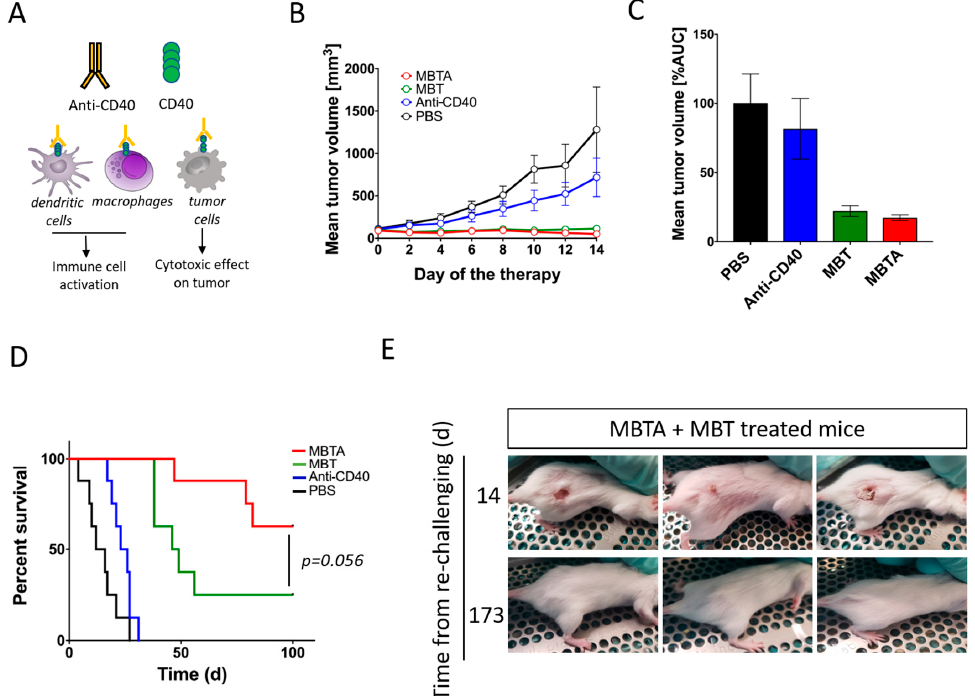
Figure 7. The effect of anti-CD40 addition into MBT therapeutic mixture and re-challenge experiment. B6(Cg)- Tyr c-2J /J mice were subcutaneously injected with MTT-luciferase cells. After tumors grew to the desired size (about 100 mm 3 ), mice were randomized into four groups ( n = 8/group): (i) the group treated with MBTA, (ii) the group treated with MBT, (iii) the group treated with anti-CD40, and (iv) the group treated with PBS. Therapy was given intratumorally on days 0, 1, 2, 8, 9, 10, 16, 17, 18, 24, 25, and 26. ( A ) Anti-CD40 is an agonist antibody binding to transmembrane protein CD40. CD40 is expressed on variety of cells, such as macrophages, dendritic cells, and some tumor cells. ( B ) The tumor volume growth is presented as a growth curve and ( C ) as an area under the curve (AUC). ( D ) The survival analysis is presented as a Kaplan–Meier curve ( p = 0.056). ( E ) Mice with complete tumor elimination from the groups treated with MBTA ( n = 5) and with MBT ( n = 2) were re-challenged on day 120 (since the start of the therapy) by 3 × 10 6 MTT-luciferase cells. All animals rejected injected tumor